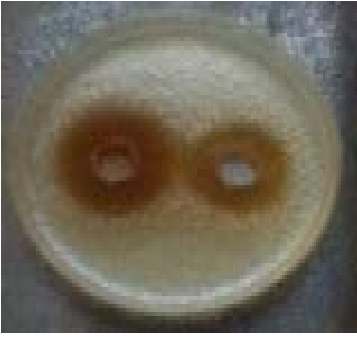
Fig. 5. Fractionation pattern of active antimicrobial substances from E. hirta ( EH) extract and their effect against MRSA, B39